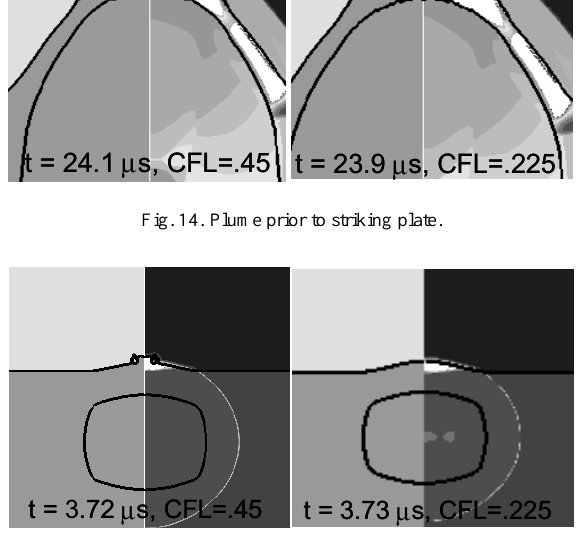
Fig. 15. Plume shortly after shock